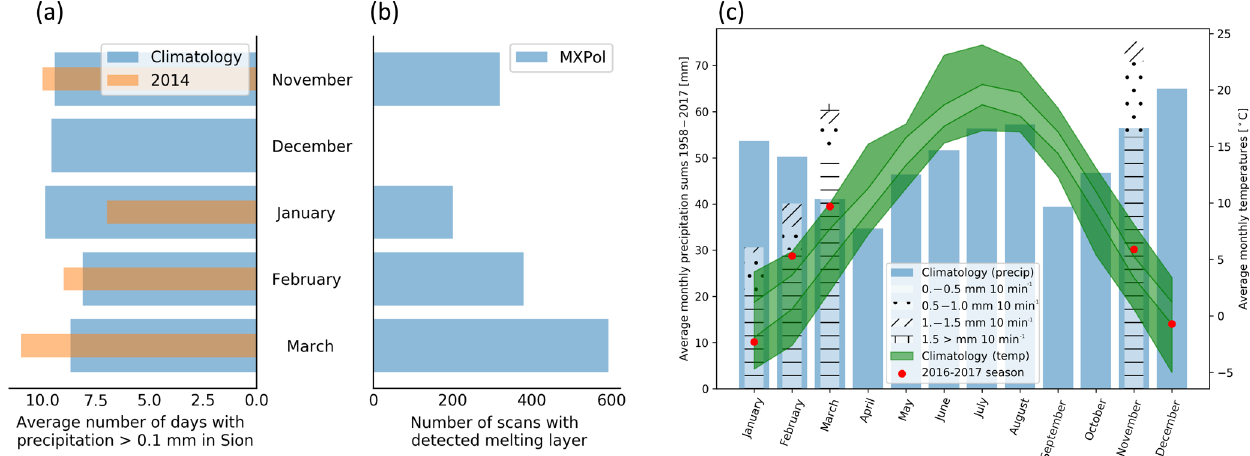
Figure 3. Meteorological conditions in Sion (~20km from MXPol) during the campaign compared to climatology, with the average number of days with precipitation for each month (a) , the number of retained scans with a detected melting layer (b) and a climatogram (c)